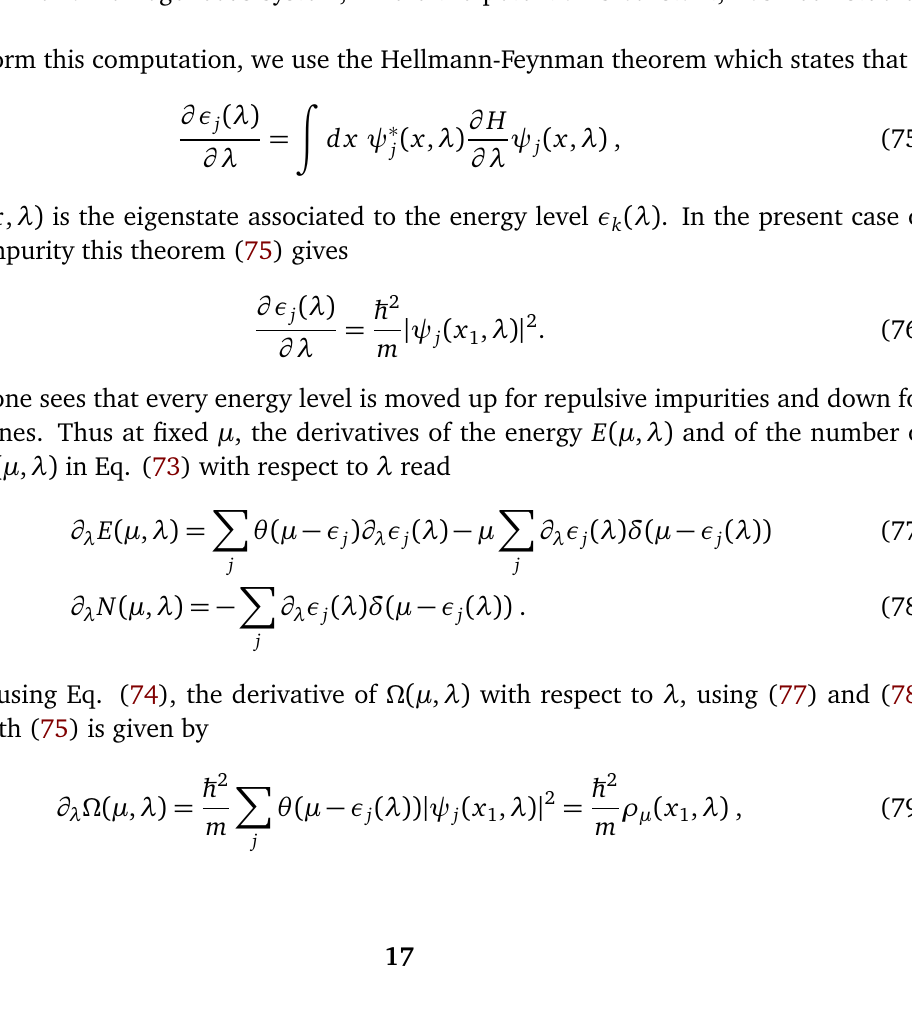
Figure 5: The relative change in the density around the point x = x (71) due to an attractive delta function potential at the point x = 0 of amplitude = γ k such that λ = − λ for γ = − 1 (solid line), and its asymptotic approximation A F (dashed line) using Eq.